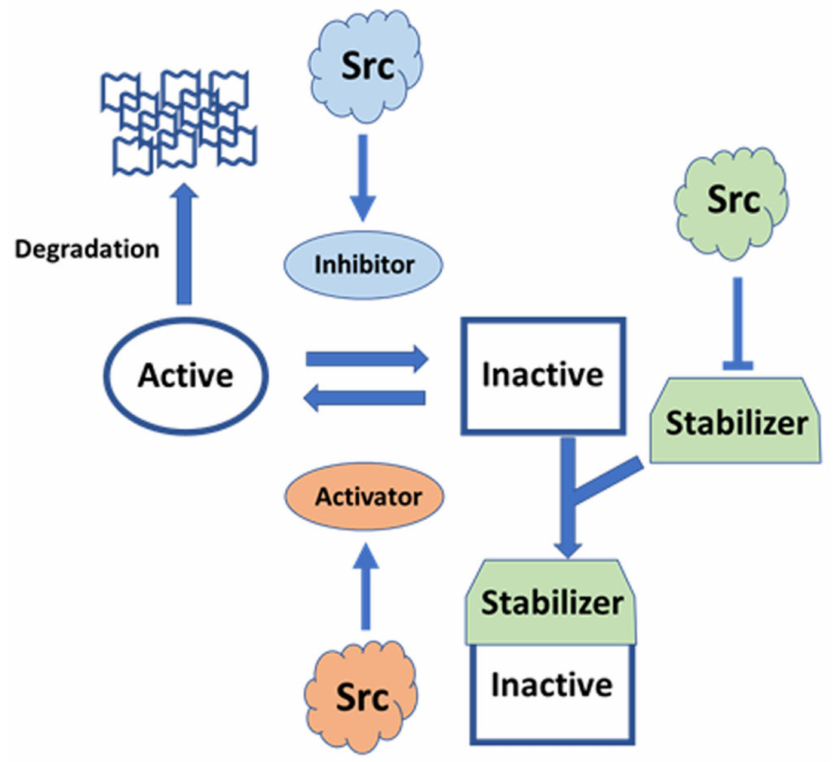
Figure 5. Pleiotropic signaling of Src involving Rho GTPase. Plasma membrane-anchored Rho GT- Pases are regulated by GTPase-activating protein (GAP) inhibitors and guanine nucleotide-exchange factor (GEF) activators. Activated Rho bound to GTP is inhibited by GAP inhibitors enhanced by Src [119,120]. Inactive Rho bound to GDP is activated by GEF activators promoted by Src [121]. GDP dissociation inhibitor (GDI) stabilizes the inactive state by inhibiting the exchange of GDP/GTP and membrane anchoring, which is inhibited by Src [122]. GDI possibly avoids Rho ubiquitin-mediated